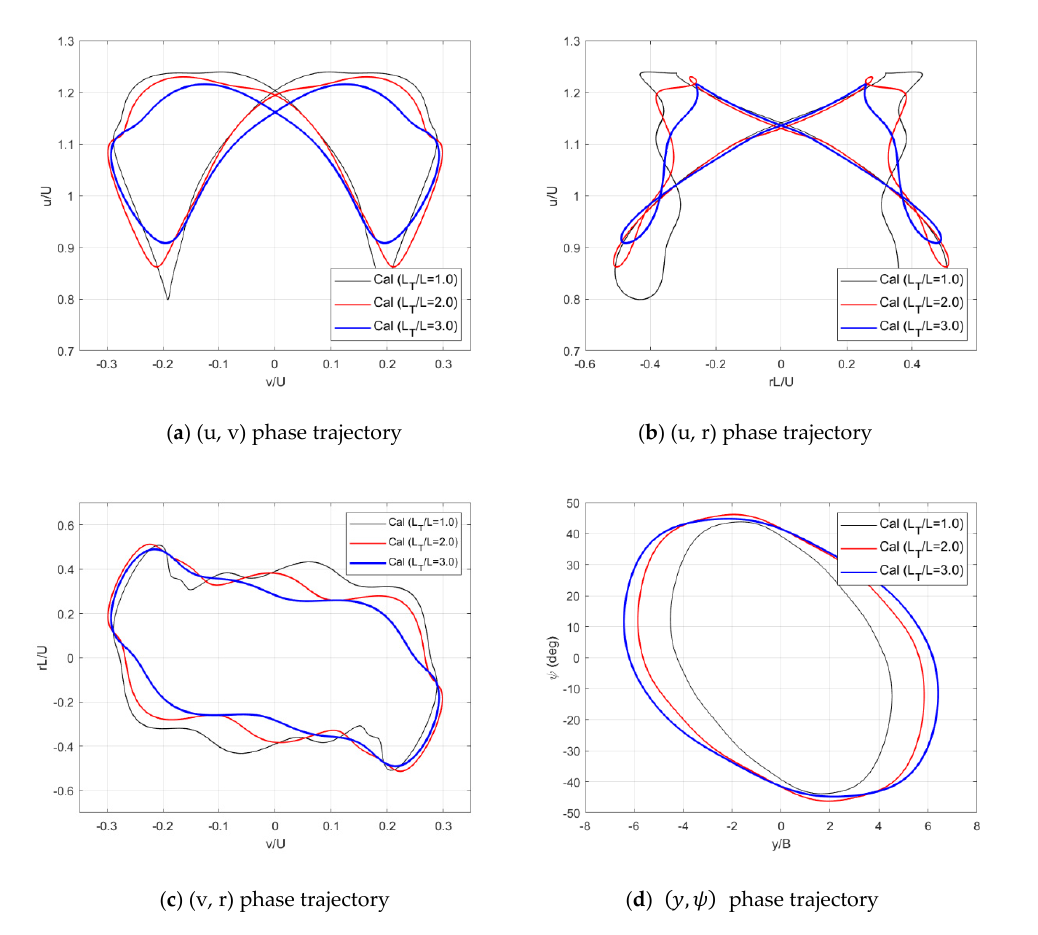
Figure 9. Phase trajectories of the towed vessel under various towline conditions ( Fn = 0.145 ). In real towing operation, towline has a nonlinear stiffness with horizontal catenary configuration.